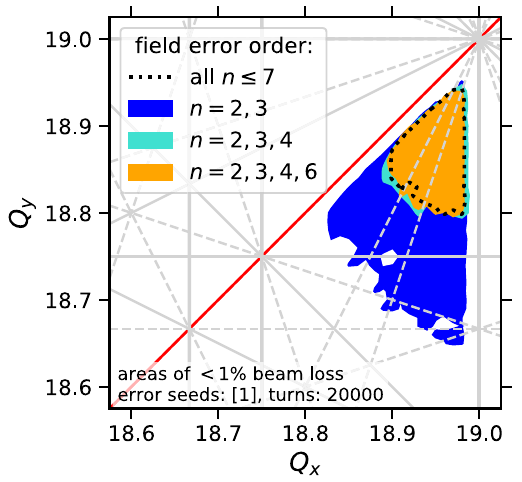
FIG. 8. Loss-free tune areas for various included field error orders n in both dipole and quadrupole magnets (FFSC simu- lations for 20 000 turns).